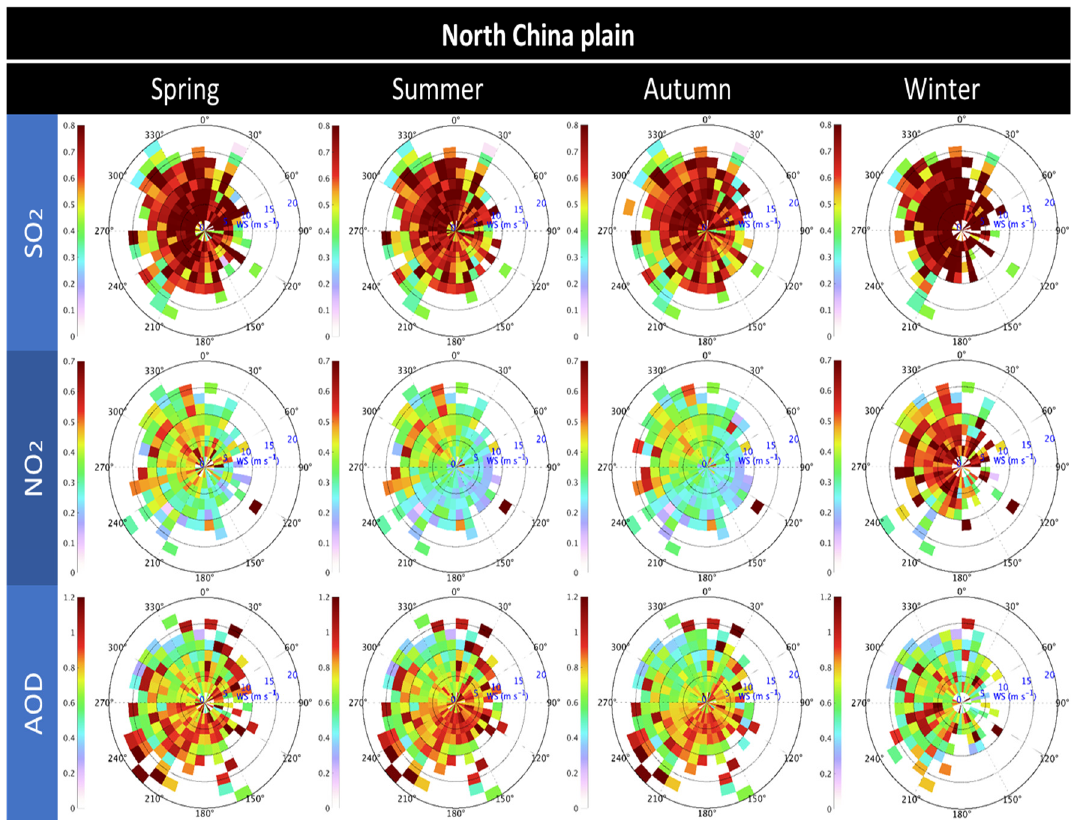
Figure 8. Summary of wind dependency of SO 2 , NO 2 , and AOD in North China Plain for each season. The shading color indicates the value of SO 2 , NO 2 , and AOD. The radial direction and radial distance represent the wind direction and wind speed at 850 mb, respectively.